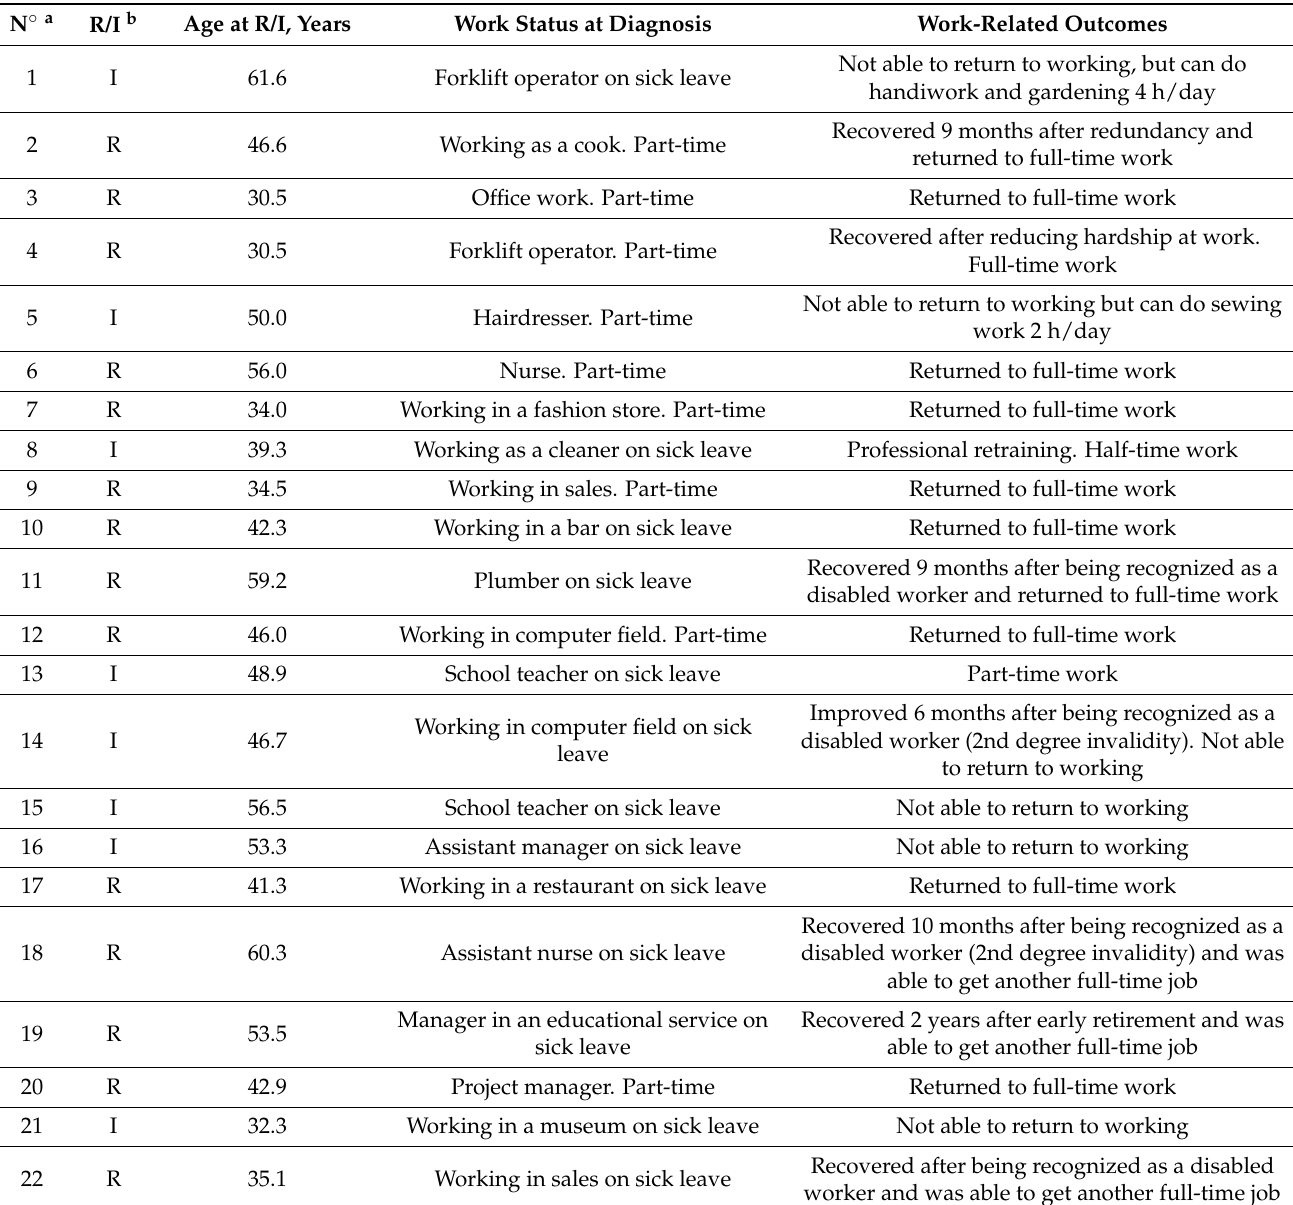
Table 3. Work-related outcomes of recovered and improved